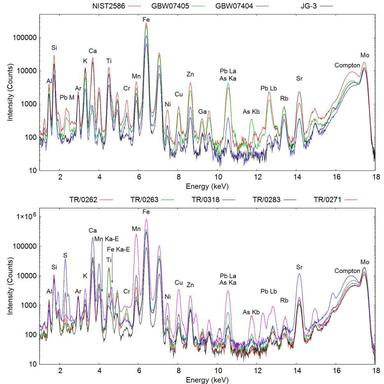
TXRF spectra for reference standards (top); TXRF spectra for natural soil pigment colors (bottom). The y-scale is logarithmic for clarity. Ka-E stands for the detector escape peak of the corresponding emission line.